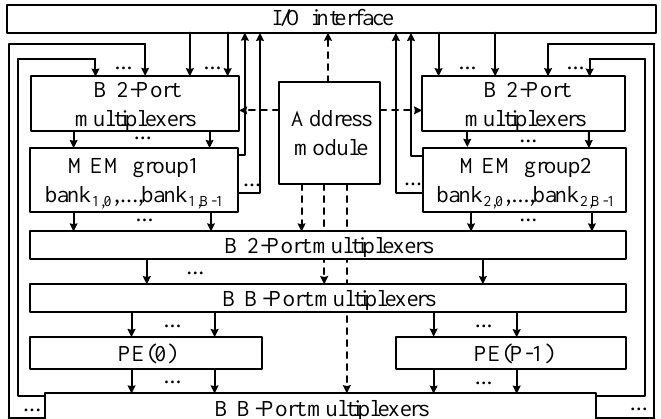
Figure 3. Proposed high-level RFFT architecture using P processing elements